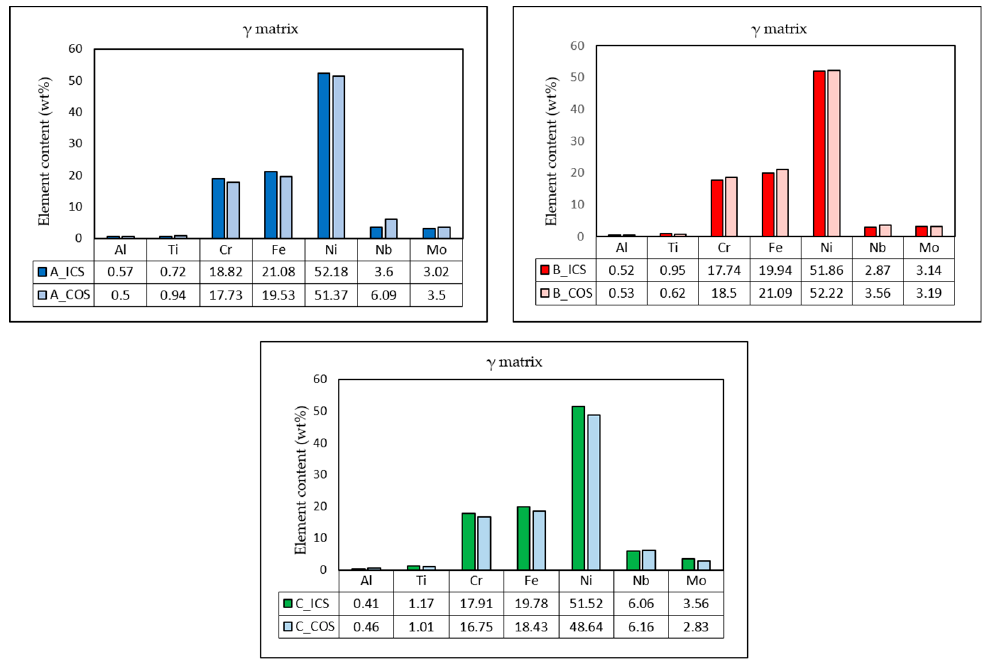
Figure 14. Comparison of γ matrix in the different deposition strategies (EDS map) .